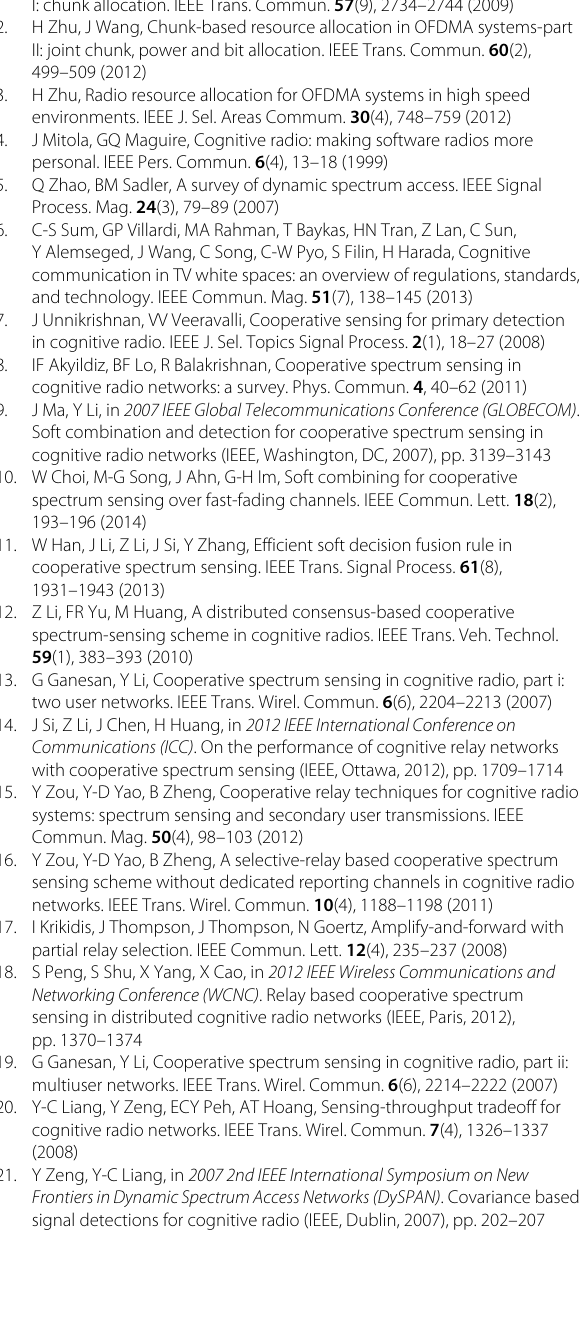
Fig. 7 Impacts of relay gain and relay channel